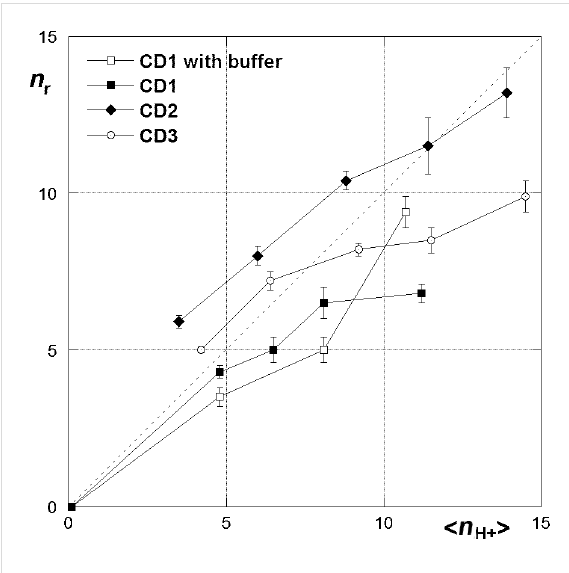
Figure 7: n r Values for the AmCD–Alg interaction as a function of < n H+ >.